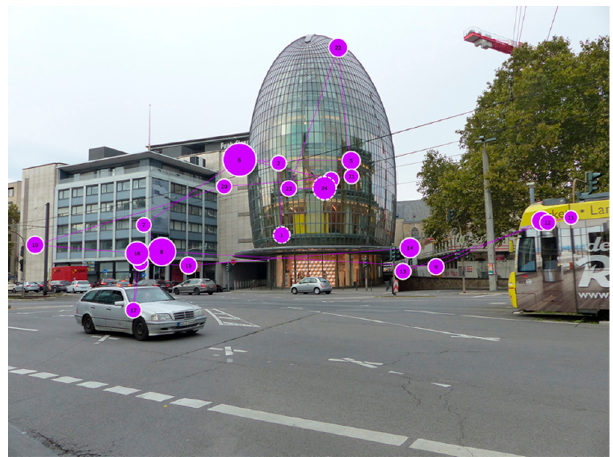
Figure 8. Gaze plot of the observation of image 2 by a single person.